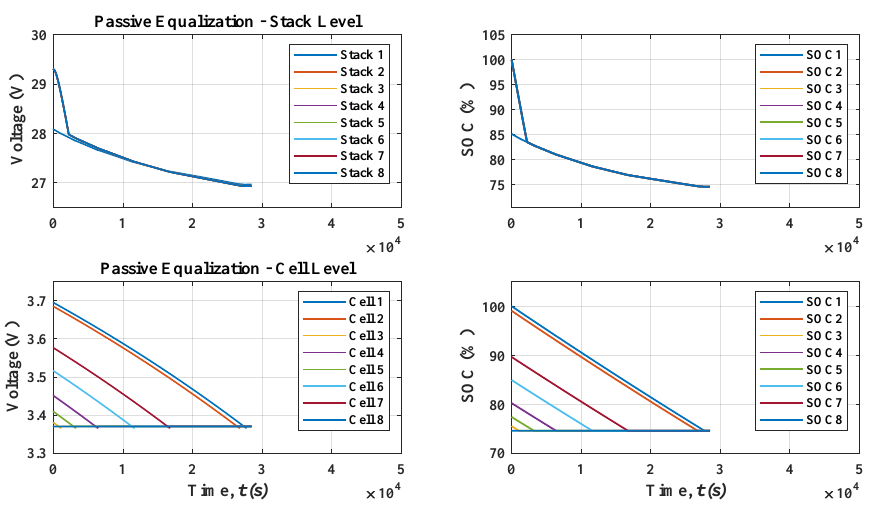
Figure 8. Passive equalization at stack and cell